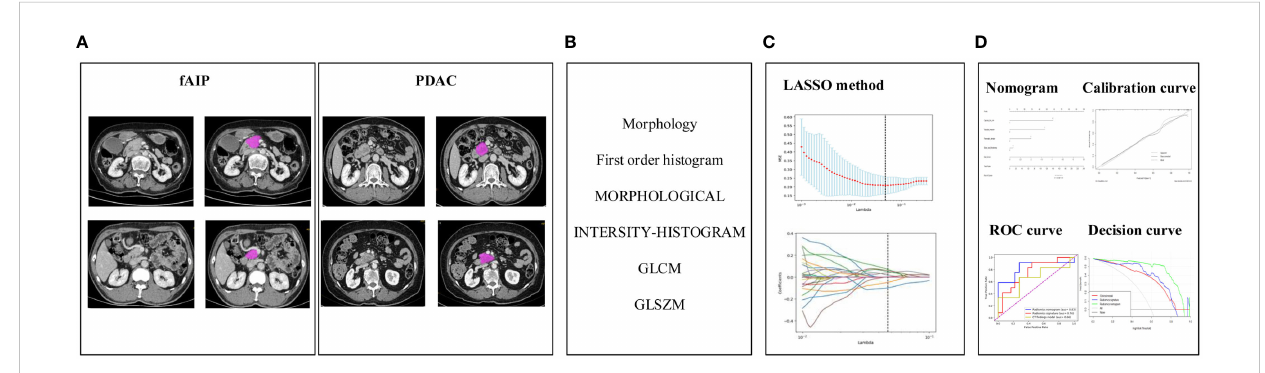
FIGURE 2 The research process including: (A) Data acquisition and segmentation; (B) Feature extraction; (C) Feature screening and (D) Radiomics nomogram construction and evaluation.